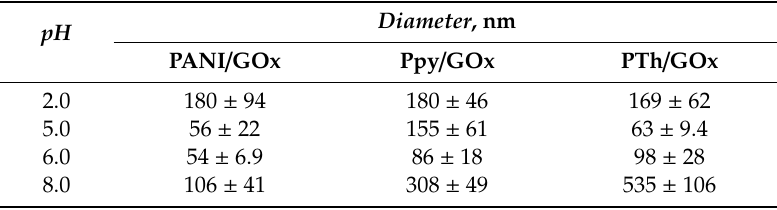
Table 1. The dependence of PANI / GOx, Ppy / GOx, and PTh / GOx composite nanoparticles diameter on the pH of solutions. The composition of polymerization solution: 0.05 mol L − 1 of glucose, 0.75 mg mL − 1 of GOx and 0.50 mol L − 1 of aniline, pyrrole, or thiophene. The particles were formed by 48 h lasting enzymatic polymerization. The diameter of particles was determined by dynamic light scattering (DLS) in 0.05 mol L − 1 SA bu ff er, pH